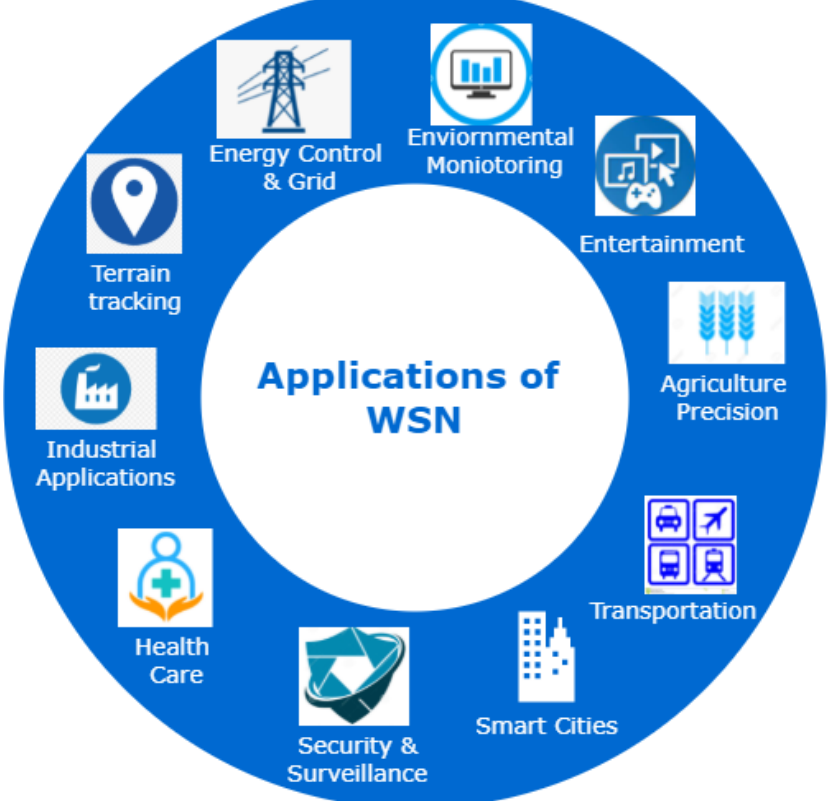
Figure 2. Application of wireless sensor network